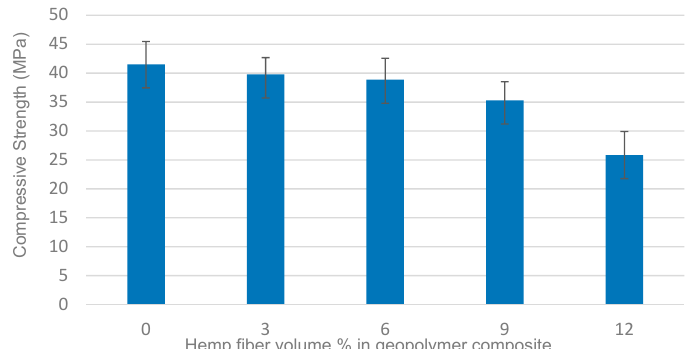
Figure 2. Effect of hemp fiber content on compressive strength of geopolymer composites.